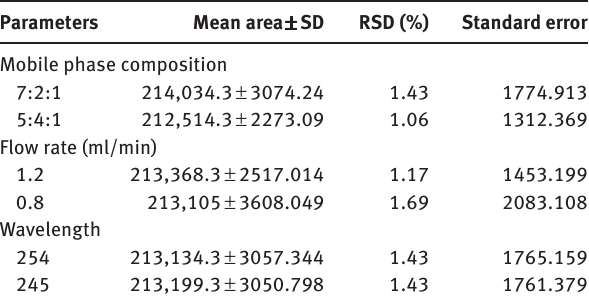
Table 6: Robustness of the proposed HPLC method (n =